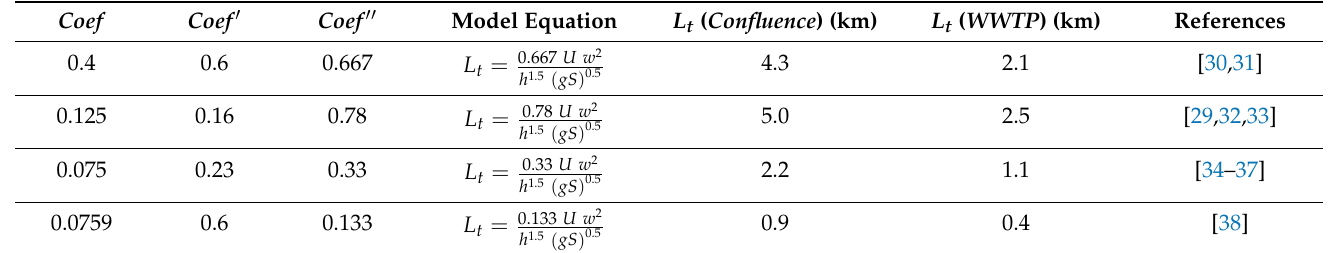
Table 3. Calculation of the transverse mixing length for confluence and for WWTP using the dif- ferent methods and equations. Our study parameters: for L t ( confluence ): U = 0.14 m/s, h = 2.5 m, g = 9.8 m/s 2 , S † = 0.0008, w = 127.62 m; for L t ( WWTP ): U = 0.081 m/s, h = 2.5 m, g = 9.8 m/s 2 , S † = 0.00027, w = 127.62